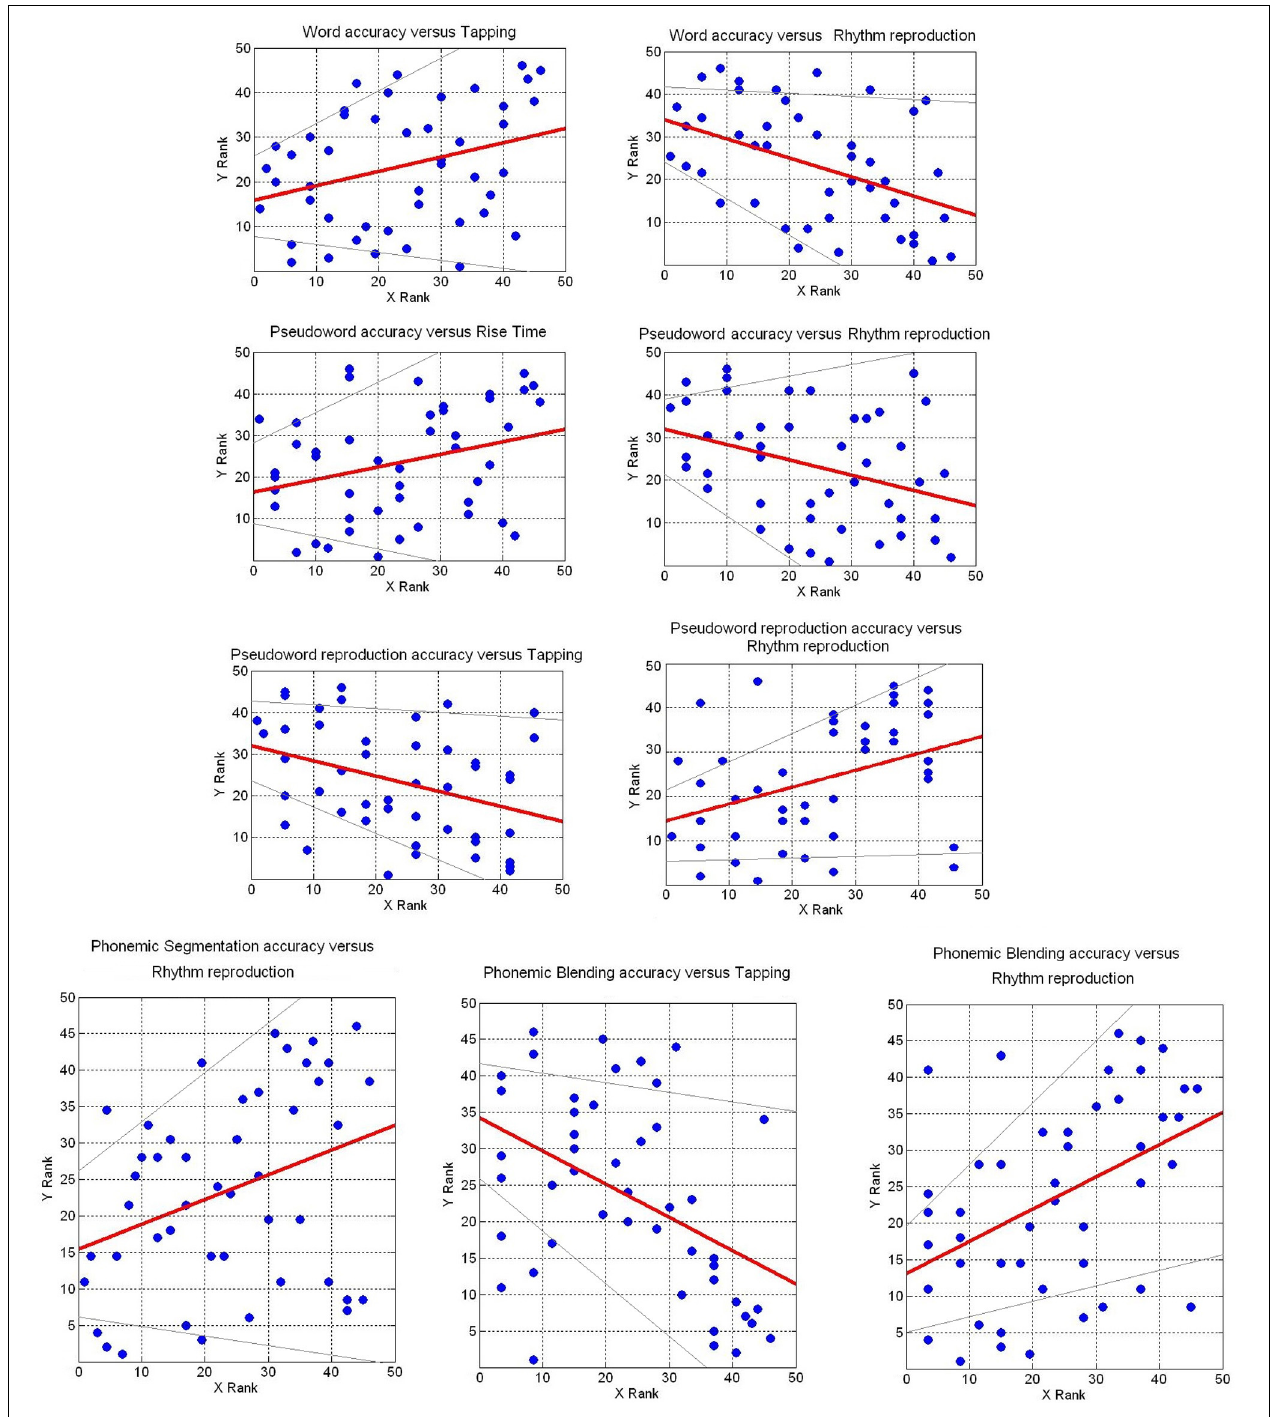
FIGURE 4 | Scatter plots of ranked variables to illustrate high r values between temporal tasks and reading and phonological tasks. Red lines indicate the linear regression. Gray lines indicate 98.5 confidence